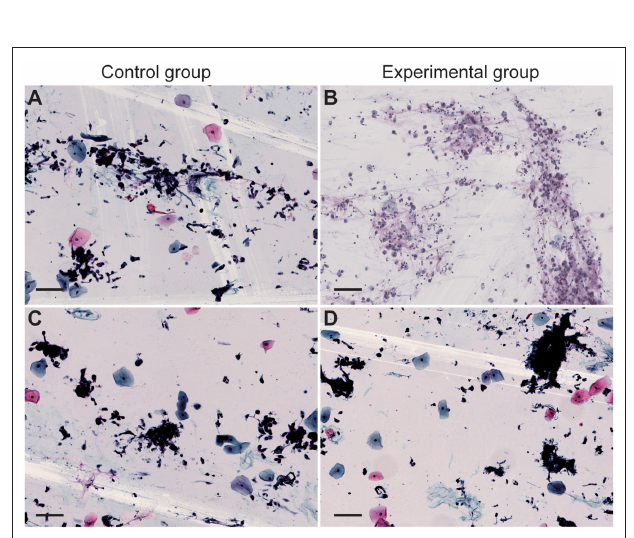
FIGURE 3 | Cell smear and liquid-based cell staining of sputum were performed. Cytological specimens were placed in a 15-ml centrifuge tube and centrifuged at 2,500 rpm for 5min. (A,B) Cell smears of the control group and the experimental group, respectively. (C,D) Liquid-based cell staining of the control group and the experimental group, respectively. Scale bar = 100 µ m.